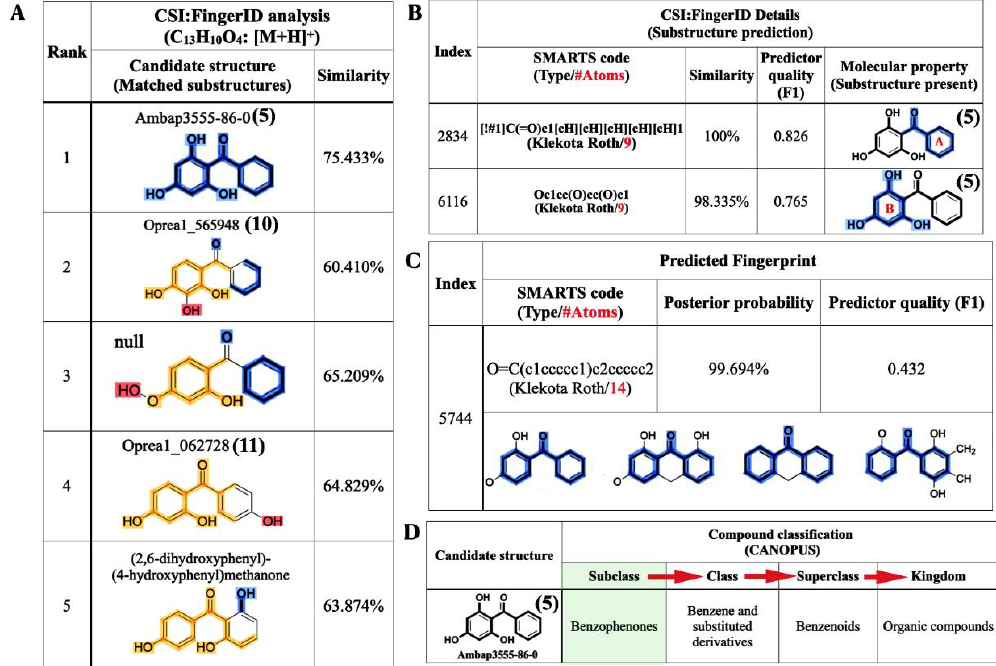
Figure 6. Structural annotations of the query metabolite (C 13 H 10 O 4 : m / z 231.0646 [M + H] + ) produced by clones harboring pETDuet-BadA-GmBPS, as found using the CSI:FingerID web service and the CANOPUS tool. ( A ) CSI:FingerID revealed that the query metabolite was perfectly matched with 2,4,6-TriHB ( 5 ) (named Ambap3555-86-0). ( B ) The example substructures that corresponded to the A and B ring systems of 2,4,6-TriHB ( 5 ) predicted to be present in the query subject. ( C ) The basic benzophenone skeleton (BBS), one the molecular properties had predicted to be present in the training data of CSI:FingerID. ( D ) CANOPUS showing the query compound that belonged to the benzophenones, which explained the organic compounds containing two phenyl groups attached via a ketone bridge. The present substructures in the query metabolite were highlighted as intense blue lines .